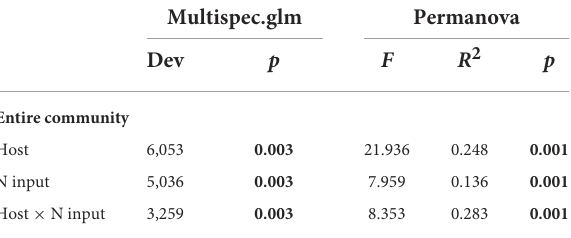
TABLE 2 Statistical testing of fungal compositional dissimilarity based on a multispecies generalized linear model calculation (multispec.glm) and a permutational multivariate analysis of variance (PERMANOVA) using Bray–Curtis distance metrics.